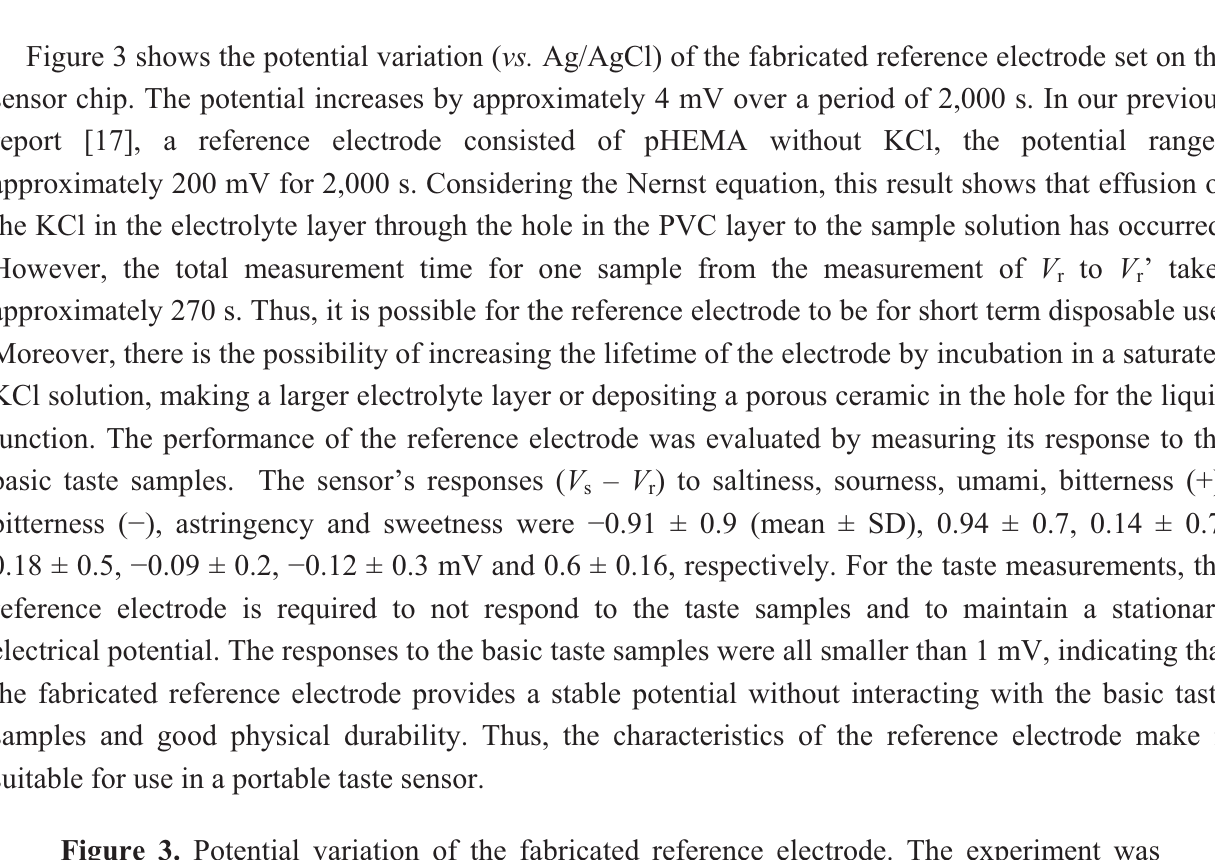
Figure 3. Potential variation of the fabricated reference electrode. The experiment was carried out in the reference